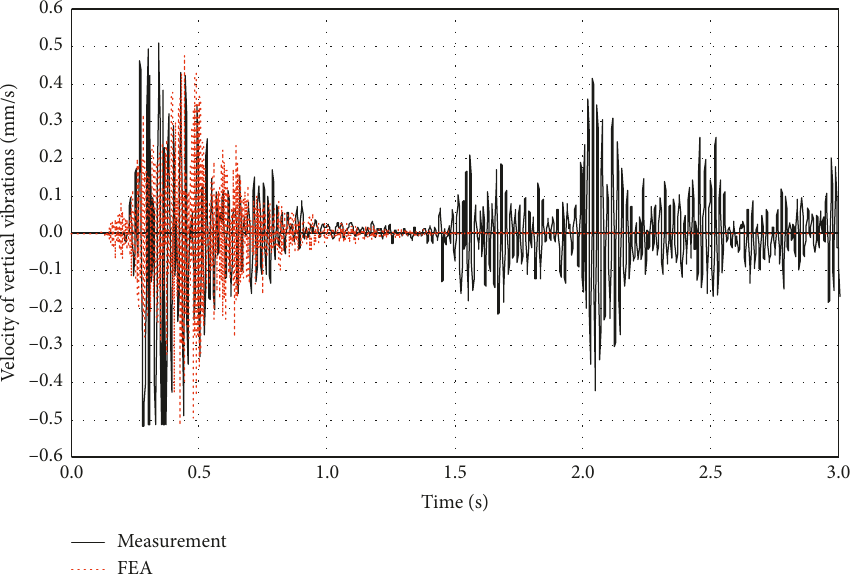
Figure 11: Measured and numerically assessed effects of multiple-mining faces